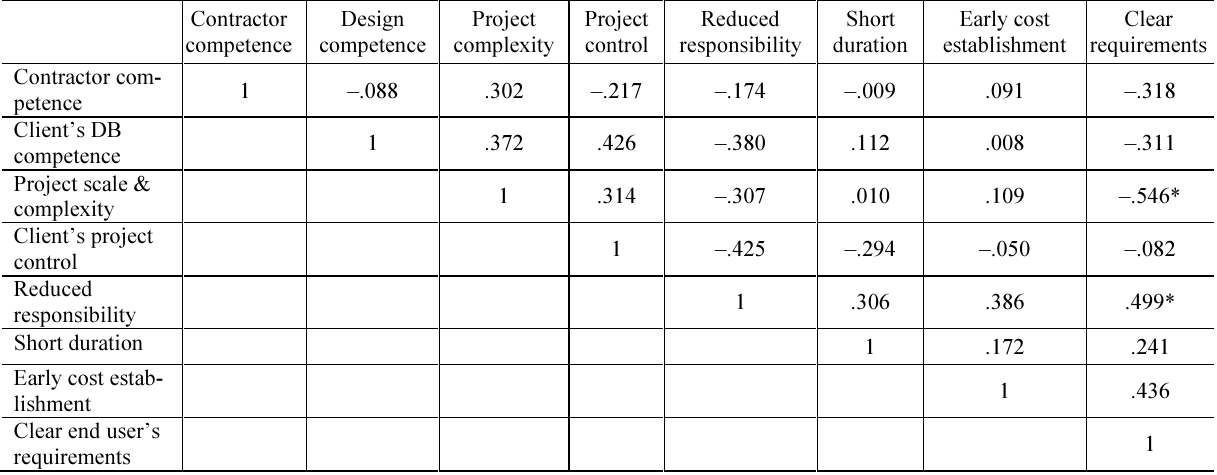
Table 6. The Pearson Correlations matrix among the top eight selection criteria